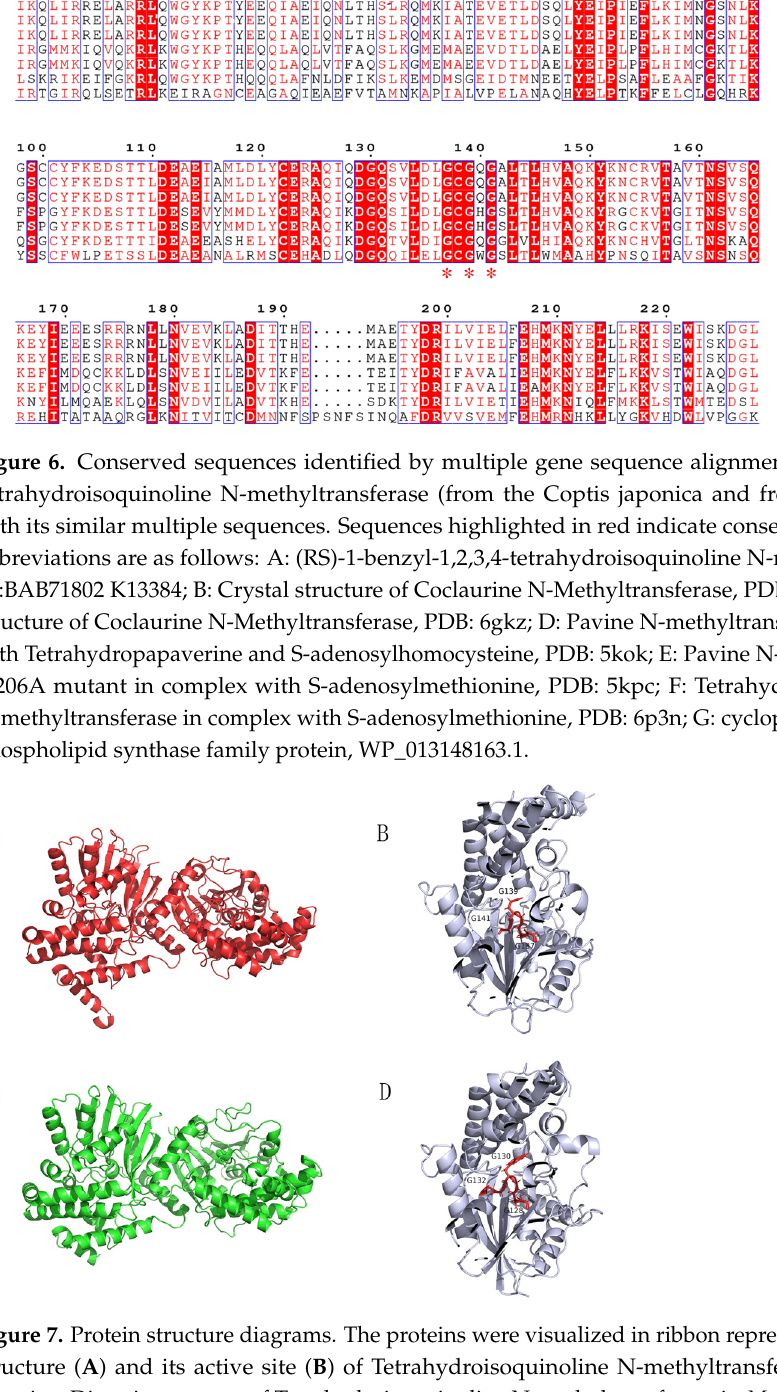
8 of 12 Figure 5. Synthetic pathway of BBR. Green arrows represent the presence of the enzyme in bacteria with increased bacterial content and bacteria isolated from soil water. The red arrow indicates that the enzyme is only present in bacteria with increased bacterial content. The sequence alignment of Tetrahydroisoquinoline N-methyltransferase (Ortholog of enzyme 9) from Methylotenera indicated a conserved region of GCGXG (Figure 6) [20].